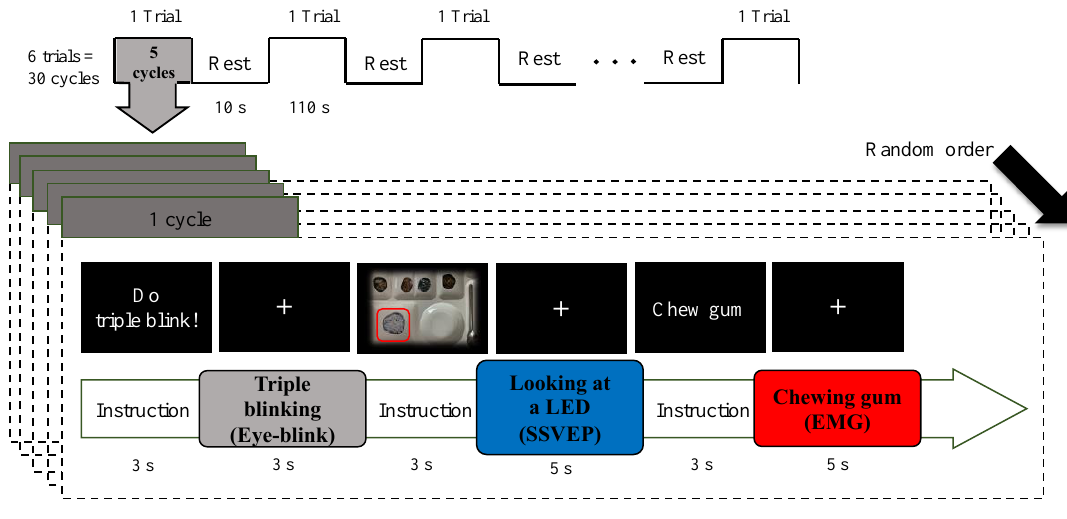
Figure 2. Schematic diagram of experimental protocol.